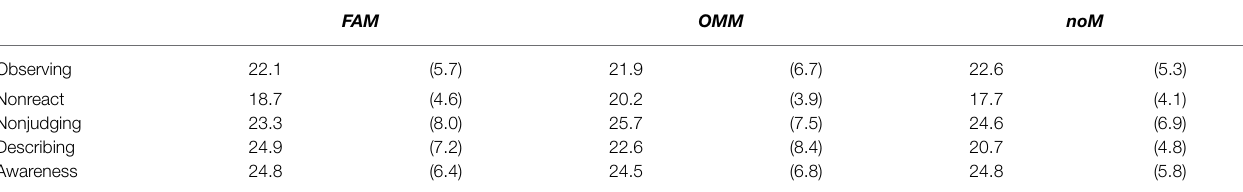
TABLE 1 | Means and standard deviations (in parenthesis) of the scores of the facets in FFMQ across groups.